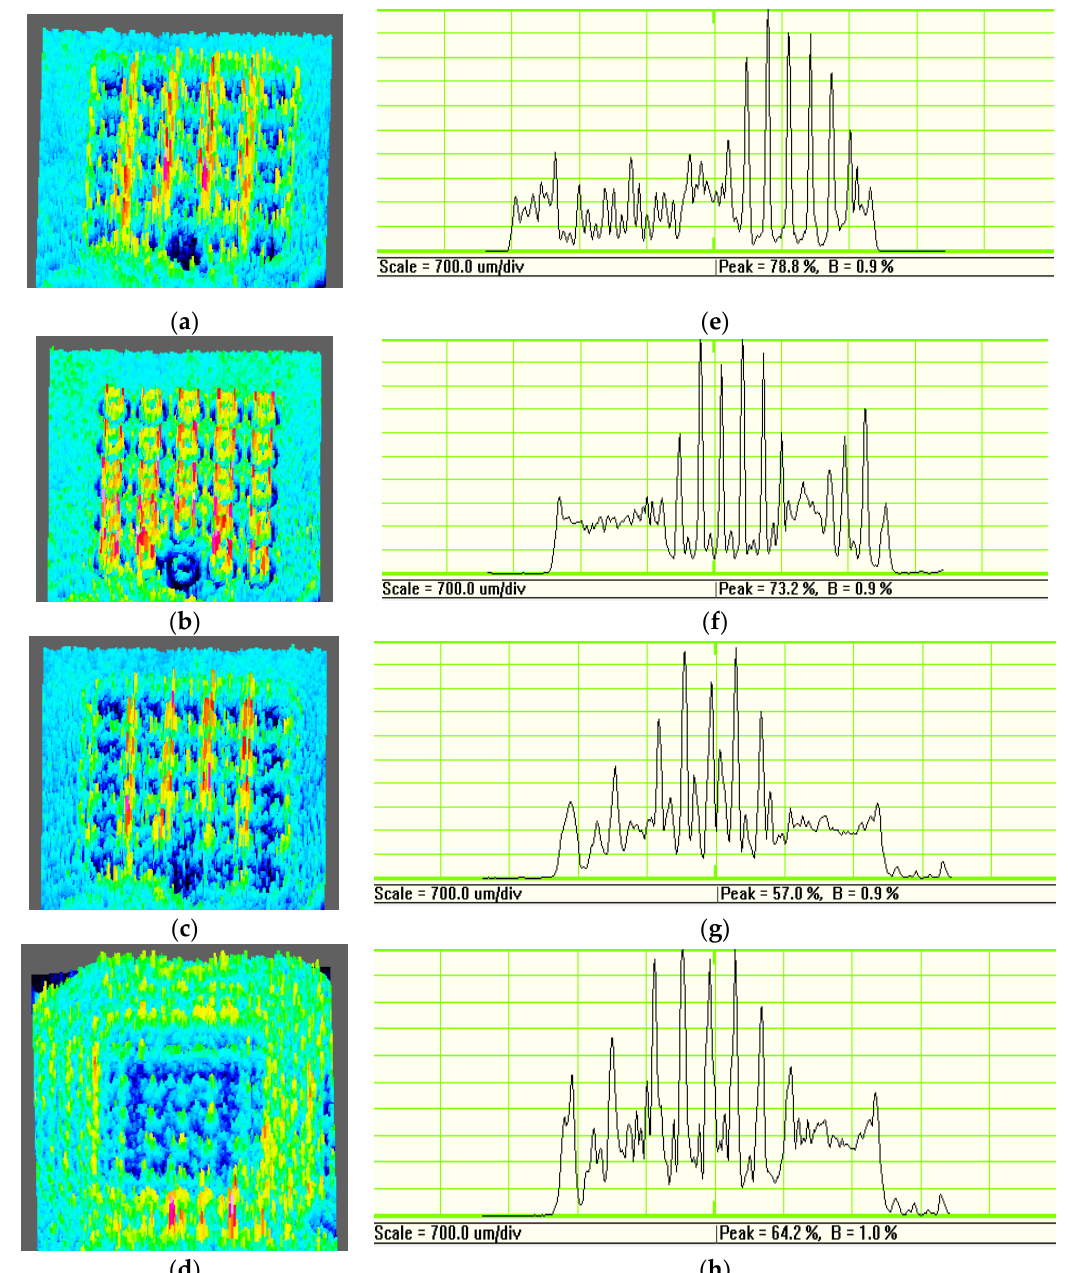
Figure 11. The three-dimension light intensity distribution of the laser beams with a center wavelength in the range of 635–671 nm, when the distance is: ( a ) 300 µ m, ( b ) 400 µ m, ( c ) 600 µ m, and ( d ) 2500 µ m, respectively. The scan and enlarged view of the annular LG beam at the focus, when the distance is: ( e ) 300 µ m, ( f ) 400 µ m, ( g ) 600 µ m, and ( h ) 2500 µ m,